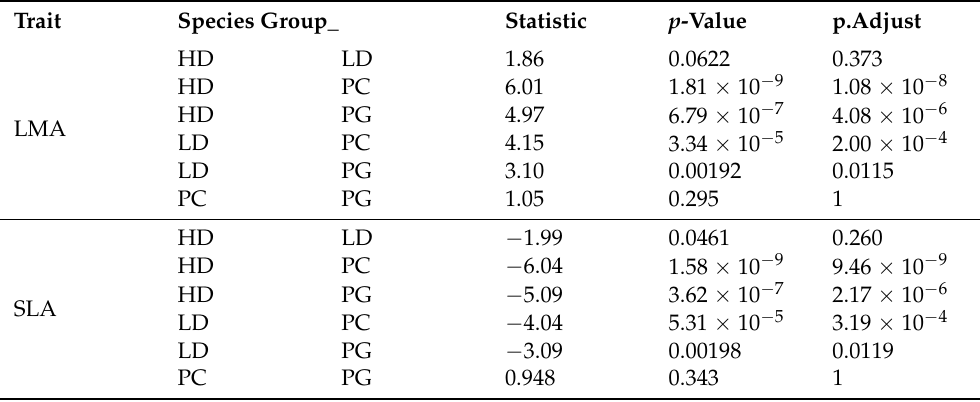
Table 5. Dunn’s post hoc test adjusted using the Bonferroni method for the two leaf traits. Vegetation structure: LMA (g cm − 2 ) = leaf mass per area; SLA (cm 2 g − 1 ) = specific leaf area for 24 subsamples collected from each invasive species (PG = Psidium guajava and HD = Hovenia dulcis ) and native species (PC = Psidium cattleianum and LD = Luehea divaricata ). Trait Species Group_ Statistic p -Value